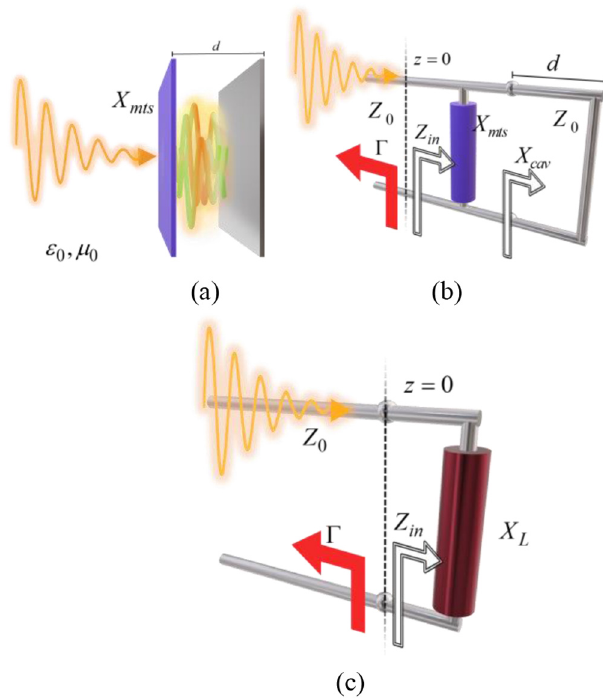
Fig. 1. Schematic representation of (a) a virtual metasurface absorber, (b) its transmission line model, and (c) circuital equivalent transmission line with lumped